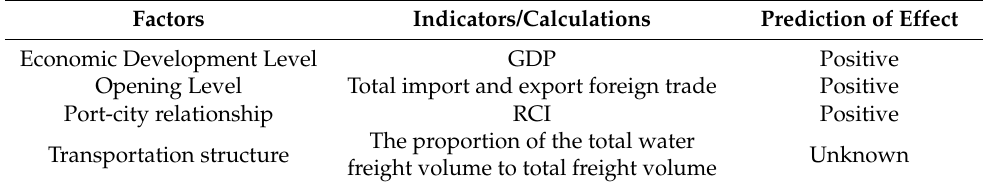
Table 4. Influencing factors and prediction of